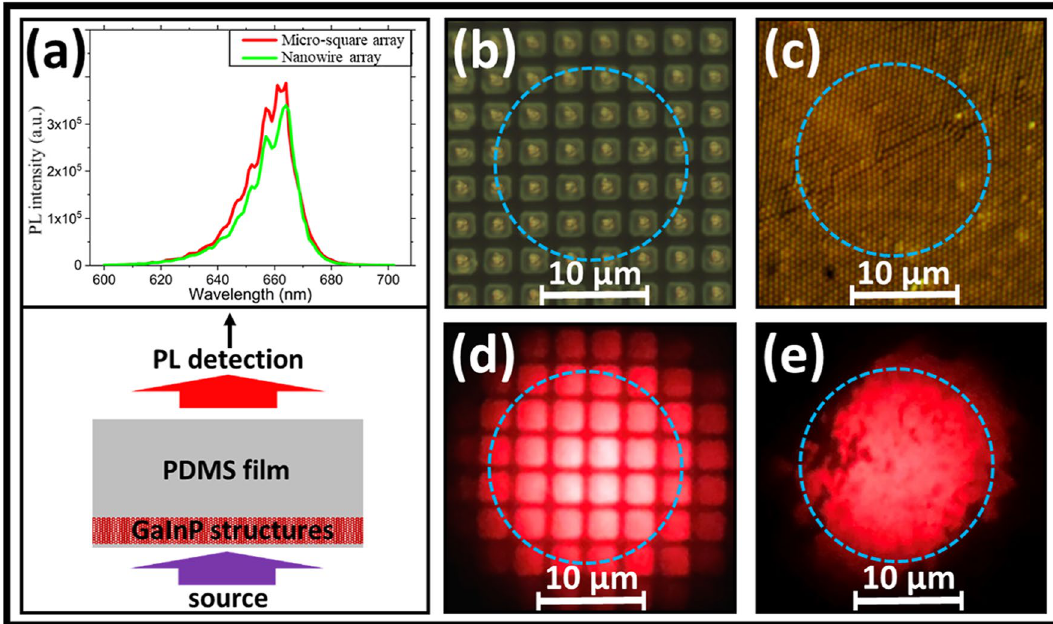
Figure 5. Color conversion results from 405 to ~ 660 nm for micro-square (MS) and tapered nanowire (NW) arrays embedded in PDMS with a spot size of ~ 17 μm and power density of ~ 2.65 μW/μm 2 . ( a ) Schematic indicating the sample orientation, direction for which the emitted PL light was measured, and the resulting PL spectra. The observed oscillations are due to interference effects due to the experimental configuration. Top view microscope images of the embedded MS and tapered NW array structures, respectively: before excitation ( b , c ) and under excitation ( d , e ), respectively. For the images in ( d , e ), a 405 nm notch filter was used before the camera